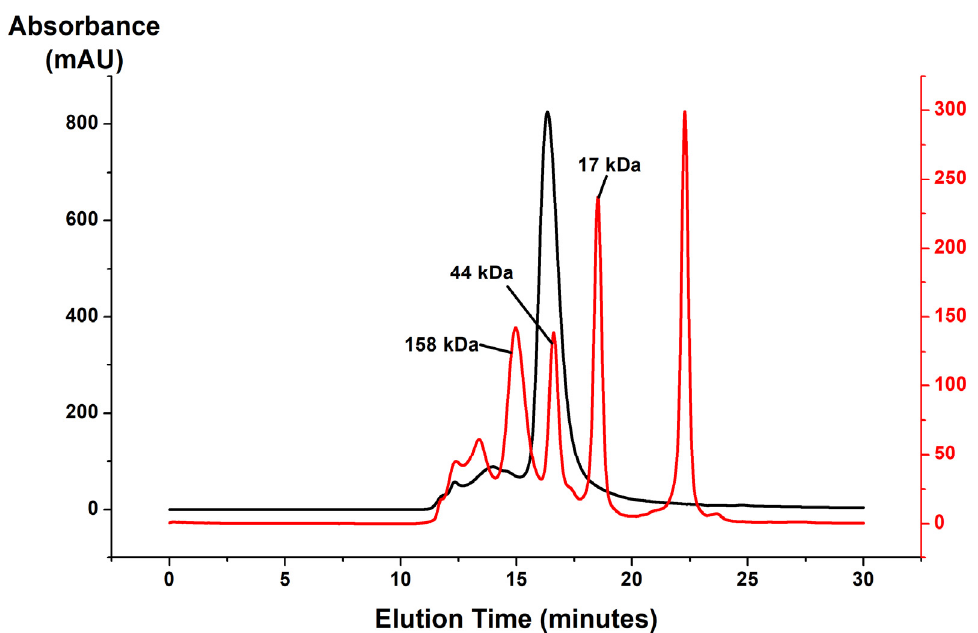
Figure 3. A representative analytical size exclusion chromatogram of purified H 1 R in solution containing 20 µM doxepin and LMNG/CHS mixed micelles is shown in black. Superimposed is a chromatogram of a solution containing molecular weight standards, shown in red. A mostly monodispersed population of purified receptor is observed for purified H 1 R, eluted at 16.3 min between the protein standards with molecular weights of 44 and 158 kDa.